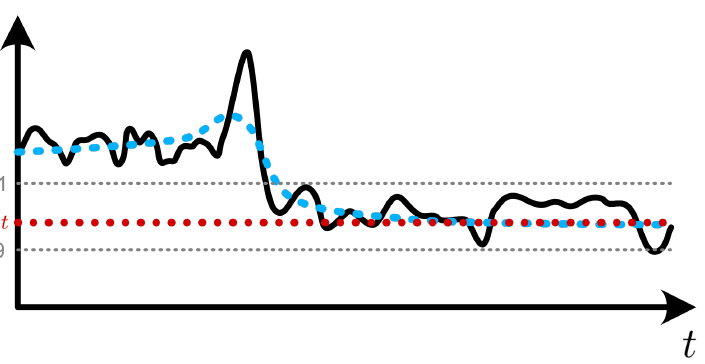
Figure 1. The gravitational acceleration estimation g est is computed as the median of the low-pass filtered (in blue) ENMEG ( E [ k ] , in black) considered between the boundary [ 0.9,1.1 ] (in